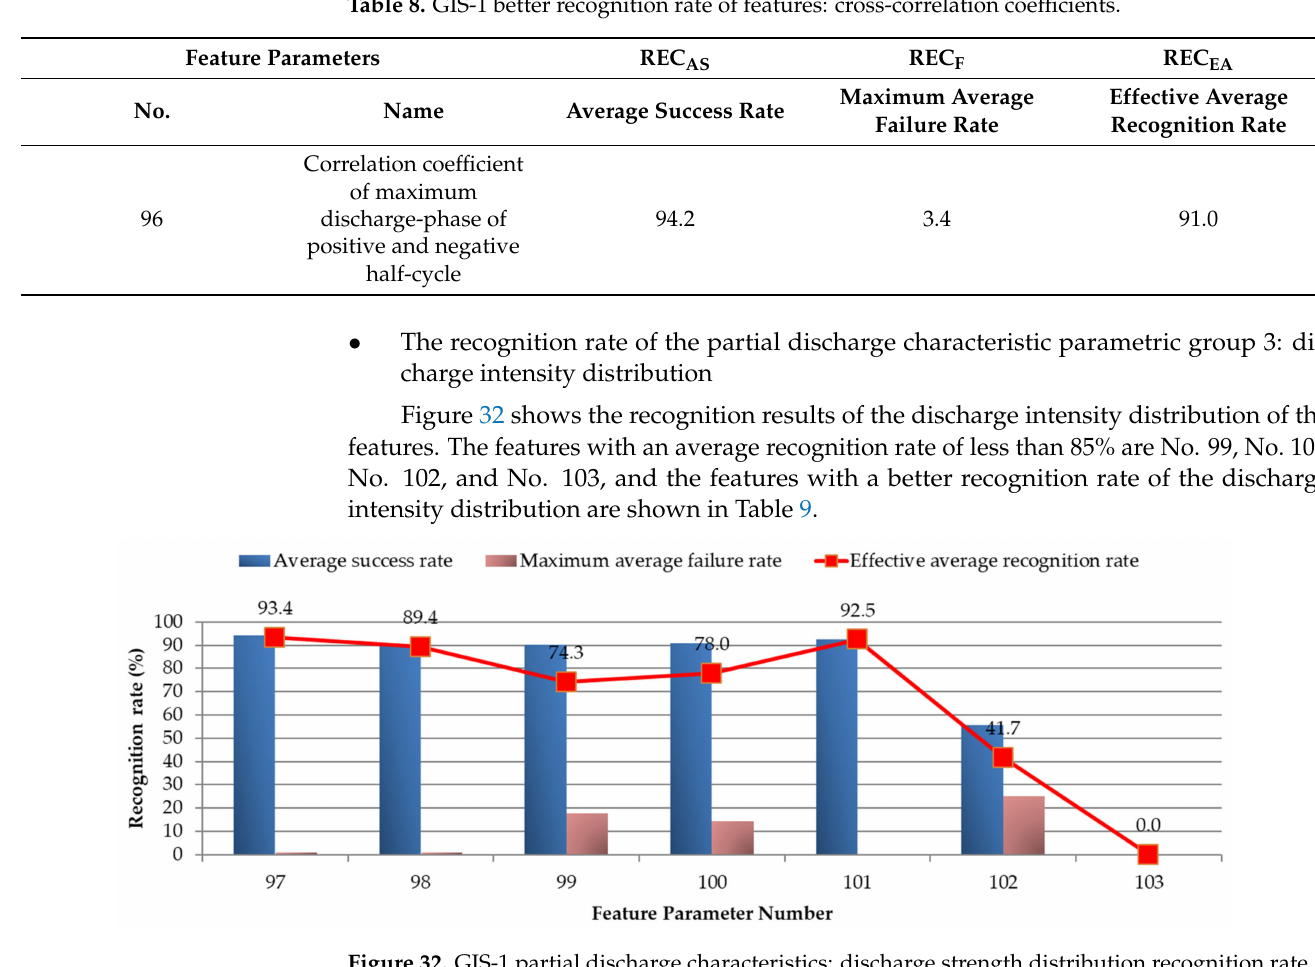
Figure 32. GIS-1 partial discharge characteristics: discharge strength distribution recognition rate. Table 9. GIS-1 best recognition rate of characteristic parameters: discharge intensity